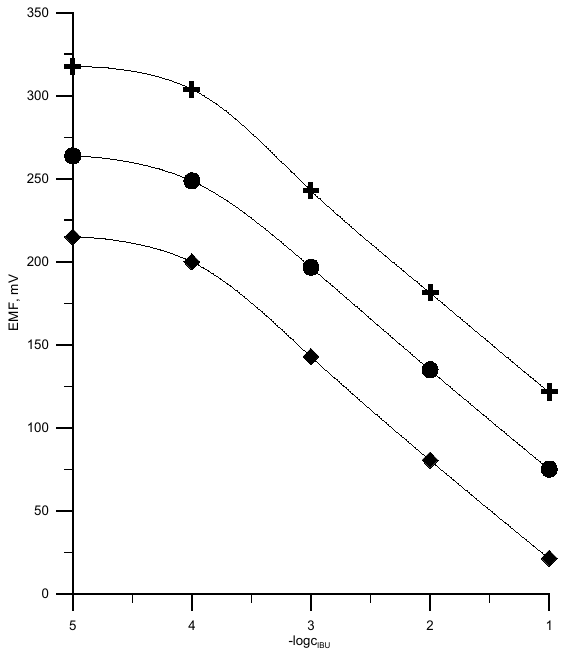
Figure 2. Calibration curves of the ibuprofen electrodes (no.1,2,3) in ibuprofen sodium salt solution pH = 7,5 (  )